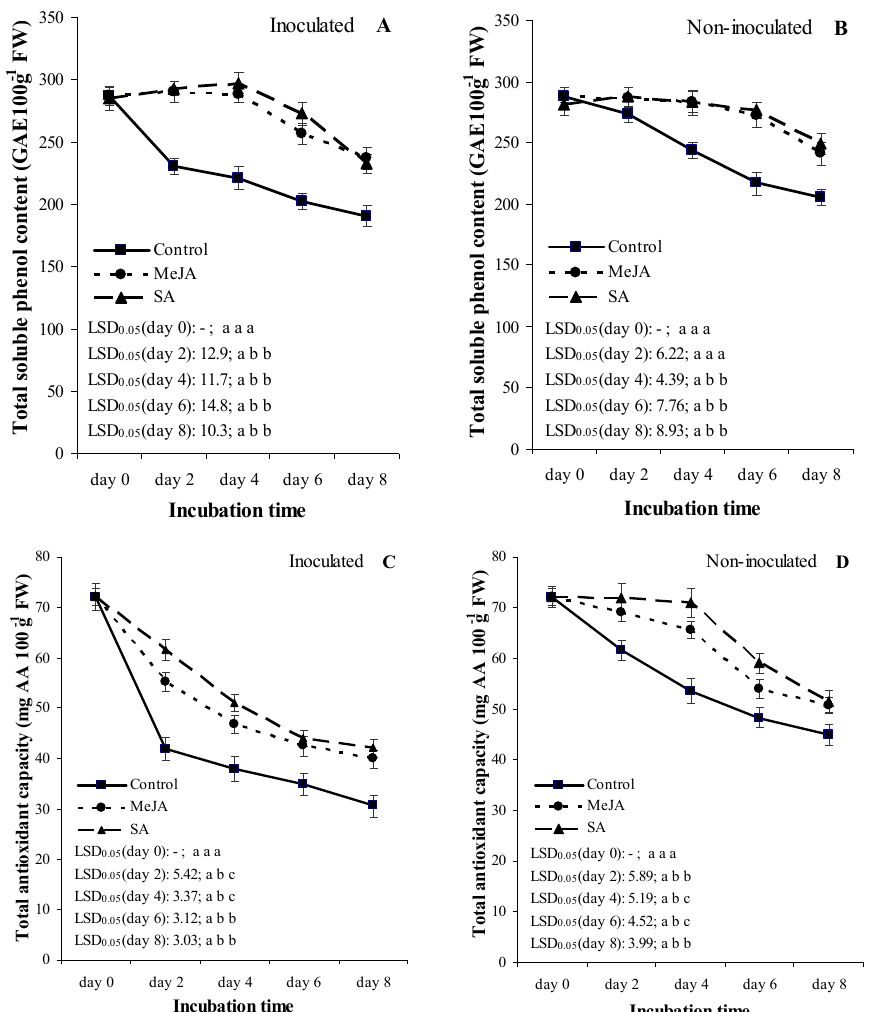
Figure 3. Effect of 2 mmol L − 1 salicylic acid (SA) and 0.4 mmol L − 1 methyl jasmonate (MeJA) on total soluble phenol content (GAE 100 g − 1 FW) ( A , B ) and on total antioxidant capacity (mg AA 100 g − 1 FW) ( C , D ) in apricot fruit (cultivar ‘Bergarouge’) in treatments inoculated with Monilinia laxa ( A , C ) and non-inoculated ( B , D ) fruits assessed at days 0, 2, 4, 6 and 8 after treatment began. Information on symbols, error bars and letters for LSD 0.05 values is presented in Figure 1.